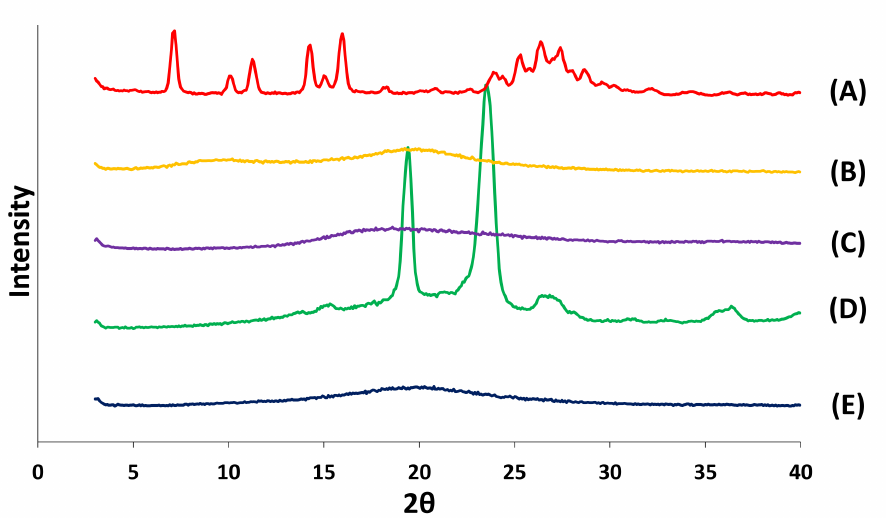
Figure 6. XRD patterns of apigenin, pharmaceutical excipients, and the apigenin-loaded film. (A), Api- genin; (B), HPMC; (C), Carbopol; (D), Poloxamer; (E), apigenin-loaded film.